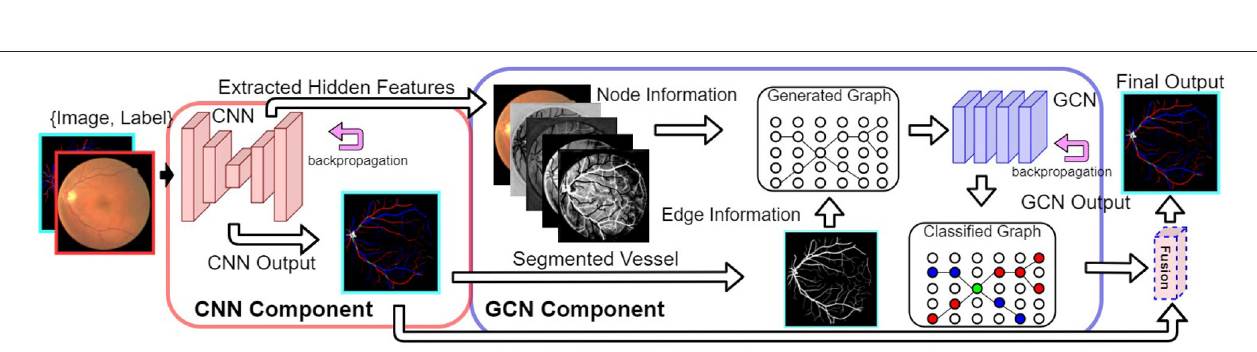
FIGURE 2 | Our proposed VTG-Net framework. Using the CNN component (in the red box), node and edge information for generating our graph representation is extracted. A GCN model is trained using the generated graphs (in the blue box) for topological feature extraction based on the CNN features. The final output is generated by fusing the CNN output and the GCN output.